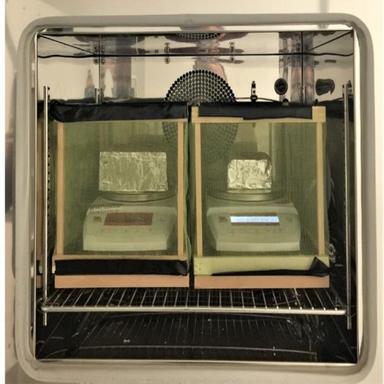
Moisture buffering setup in climate chamber.